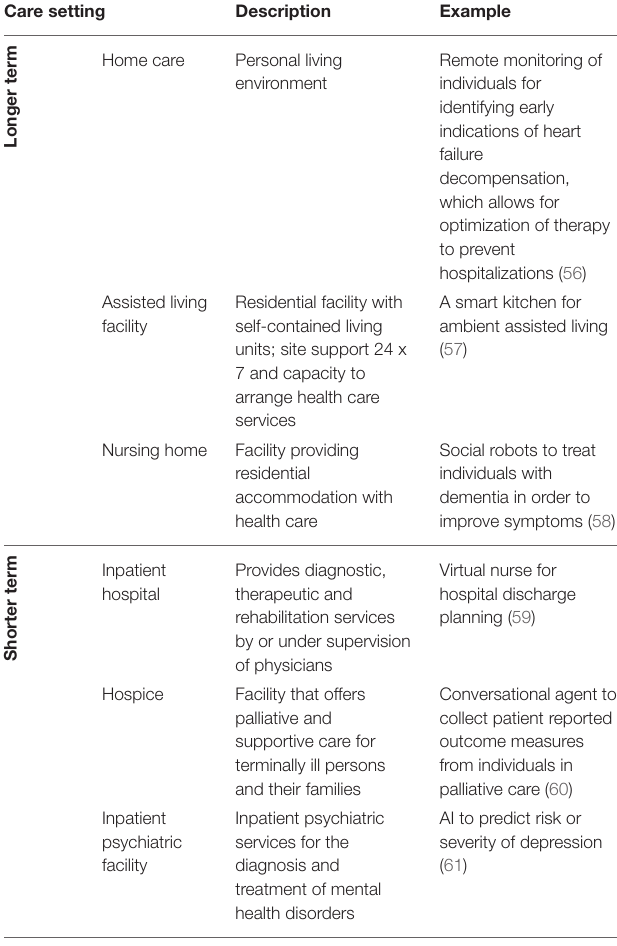
TABLE 1 | Classification by care setting. Care